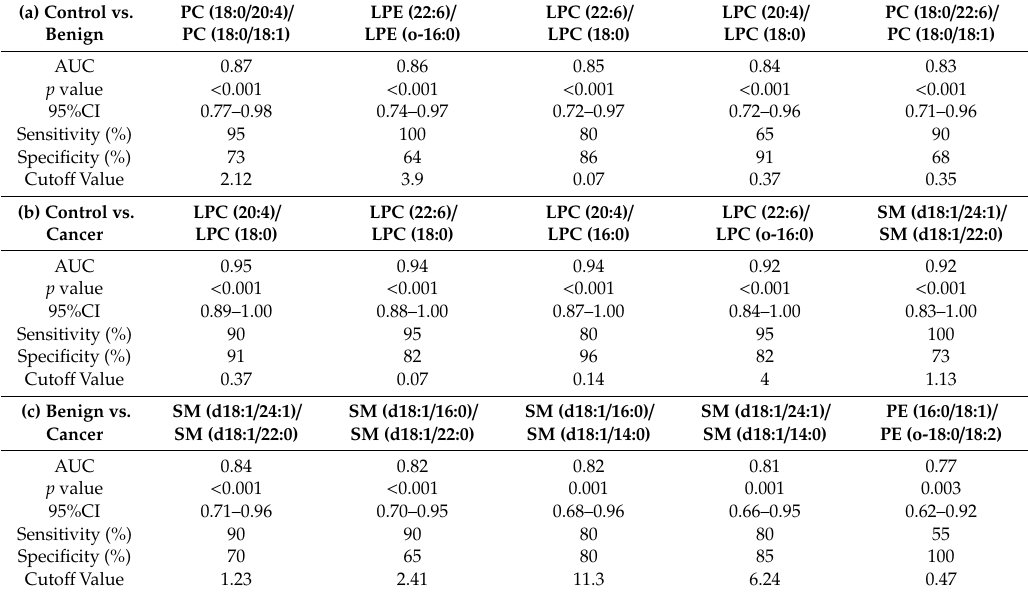
Table 3. The area under curves (AUCs) for phospholipids, lysophospholipids, sphingomyelin, their 95% confidence intervals (CI), p values, sensitivities, specificities, and cuto ff values for ( a ) control vs. benign, ( b ) control vs. cancer, and ( c ) benign vs.